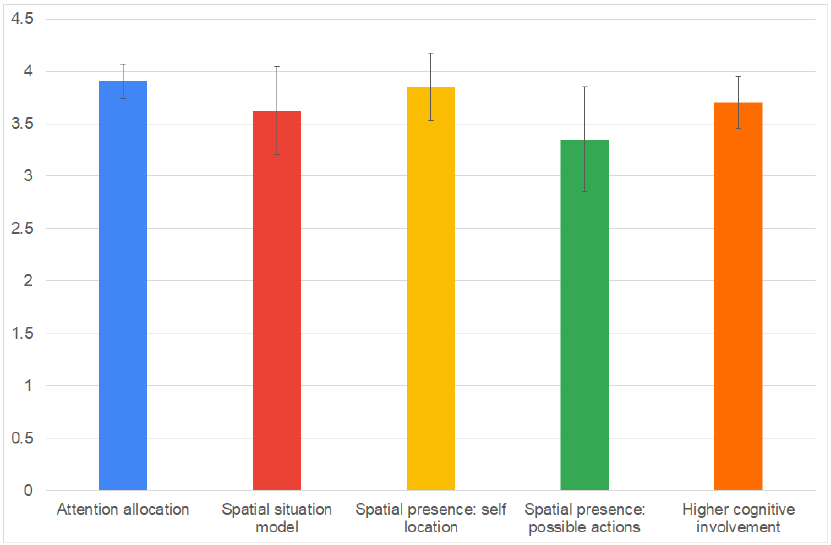
Figure 7. Histogram comparing the scores of user experience